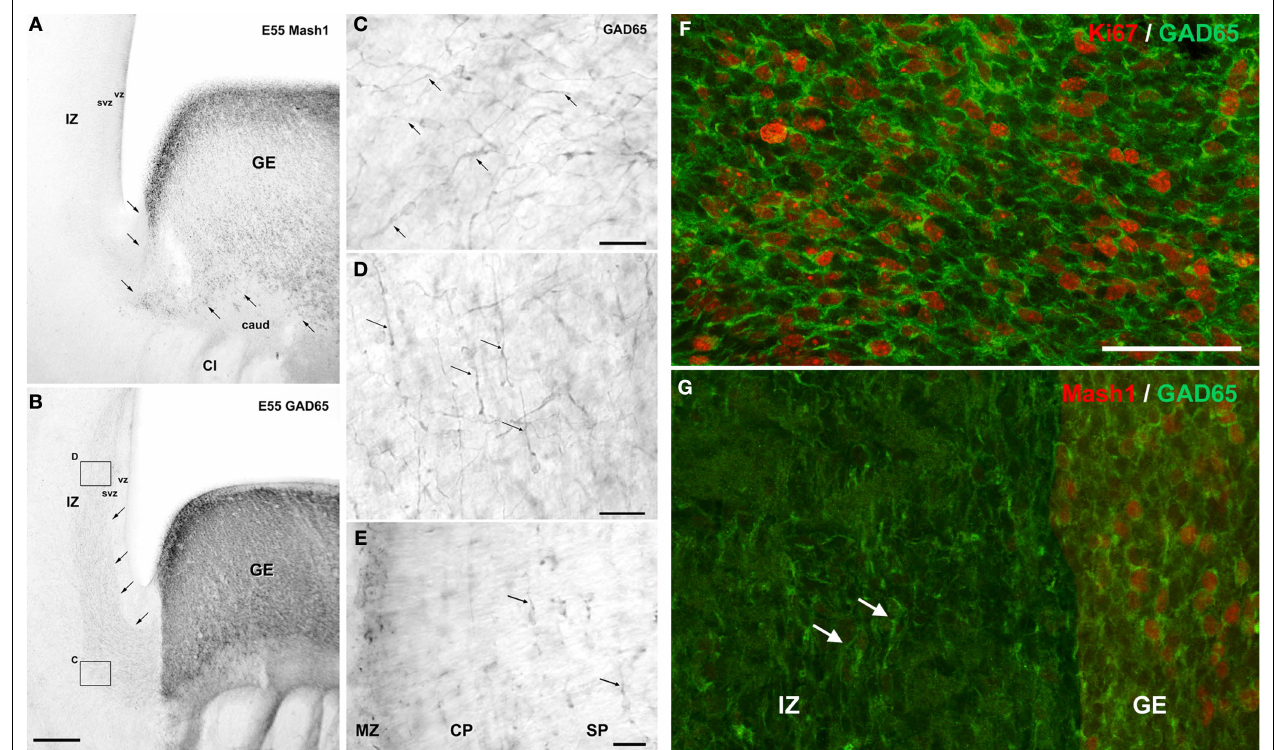
FIGURE 3 | Tangential migration of GABAergic neurons in coronal sections of a monkey fetus at embryonic day (E) 55. (A) Mash1 containing progenitors were present in the ganglionic eminence (GE) but not in the neighboring structures including the caudate nucleus (caud), capsula interna (CI), and adjacent zones of the dorsal telencephalon: ventricular zone (VZ), subventricular zone (SVZ) and intermediate zone (IZ). Arrows indicated the border between GE and adjacent structures. (B) GAD65 containing progenitors were present almost exclusively in the GE. In addition a stream of post-mitotic-like, GAD65-containing neurons extending from the GE to dorsal telencephalon was observed in the lower IZ/upper SVZ. Arrows indicate the deeper border of this stream. Boxes: magnifi ed regions in panels (C) and (D) . (C) GAD65-containing cells with a characteristic morphology of post-mitotic migrating neurons, including a leading